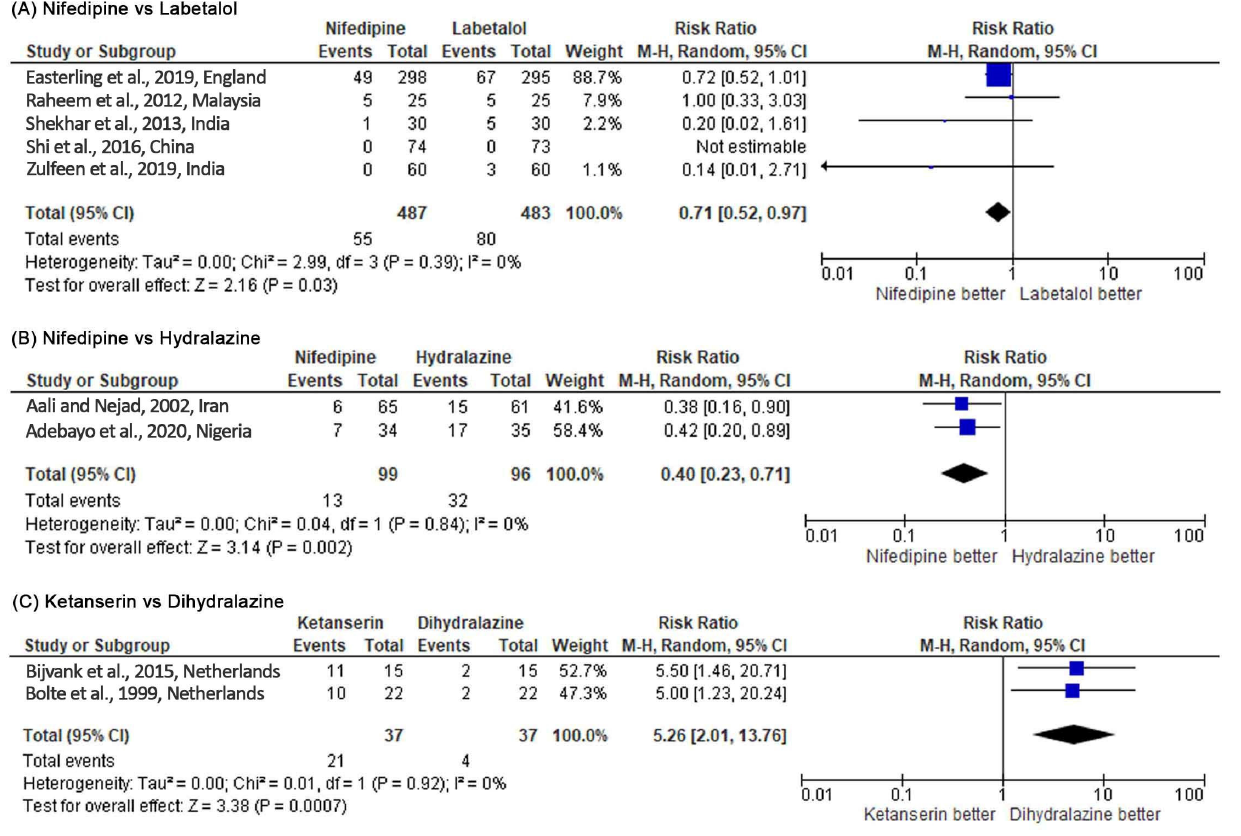
Figure 4. Meta-analysis outcome 1: comparison of antihypertensive medication effectiveness in con- trolling blood pressure assessed by the risk of persistent severe hypertension incidence. The risk ratio (RR) was used to interpret the risk of persistent severe hypertension incidence after administering the drug. p -value in the overall effect shows the significance of the RR.